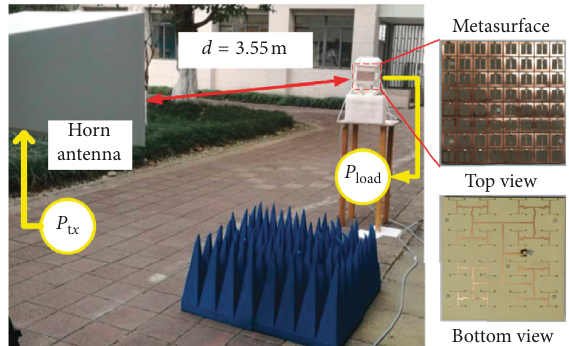
Figure 9: Efficiency measurement setup and the 8 × 8 metasurface array and a power meter connected to the metasurface output port. The measurement system has been fully calibrated with cable losses and the transmitted power at each frequency point of the measurement.